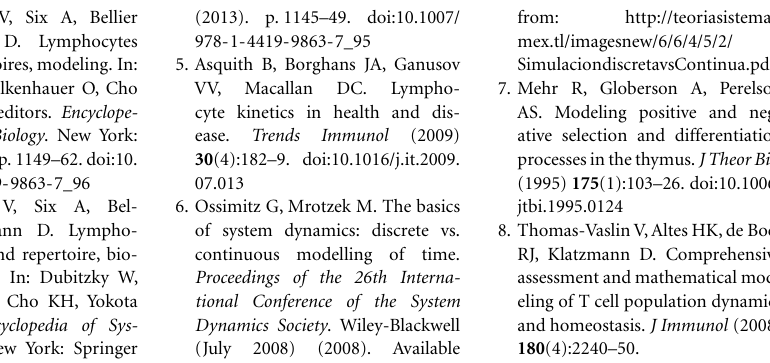
FIGURE 2 | Refactoring the automata single-cell model of thymocyte differentiation and migration (20) into a computer executable visual language. The 40 pages of Fortran code is transformed in computer UML state-transition diagram.This diagrams describes the experimentally observable heterogeneity, and the biologically relevant parallel processes (underlined in red box). As in Figure 1 , input, output, and oriented transitions are described in the state-transition diagram. Parallel state-transitions represent the evolution of single cells in the thymus,